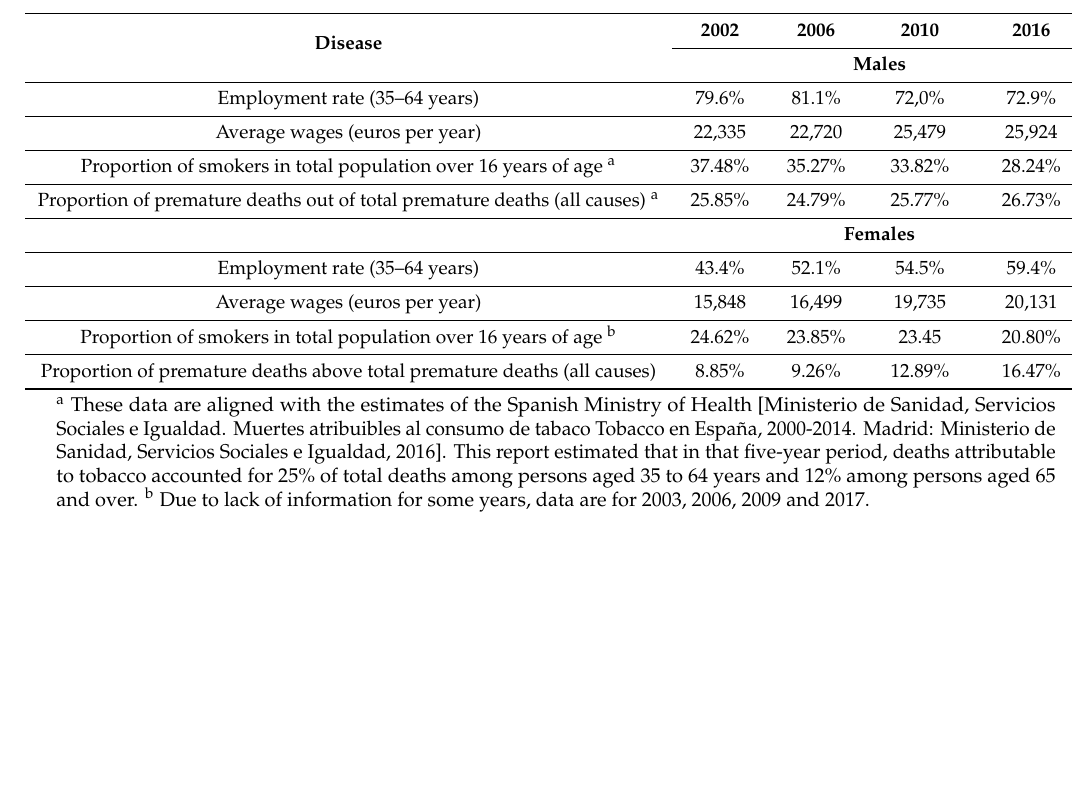
Table A2. General description of some